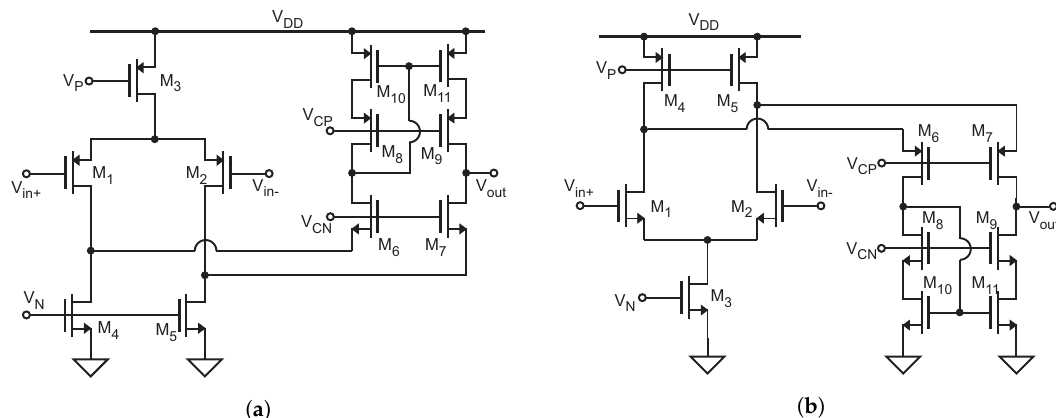
Figure 4. Implementation at transistor level of the Operational Transimpedance Amplifiers: ( a ) PMOS input; and ( b ) NMOS input [29].